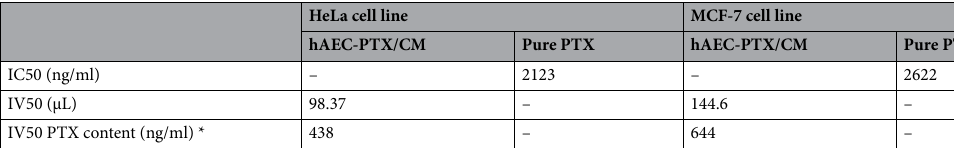
Table 1. Anti-proliferative effects of hAEC-PTX/CM on HeLa and MCF-7 cell line. *The concentration of PTX present in the IV50 dilution of